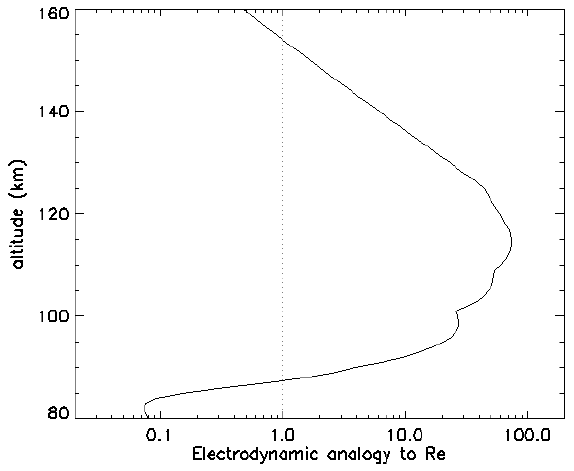
Fig. 1. The proposed (Hall, 2000) analogy to the Reynolds number for ion-drag induced neutral motion as a function of altitude and using a typical neutral wind speed profile from Fujii et al. (1998). The vertical dotted line indicates the unity condition.